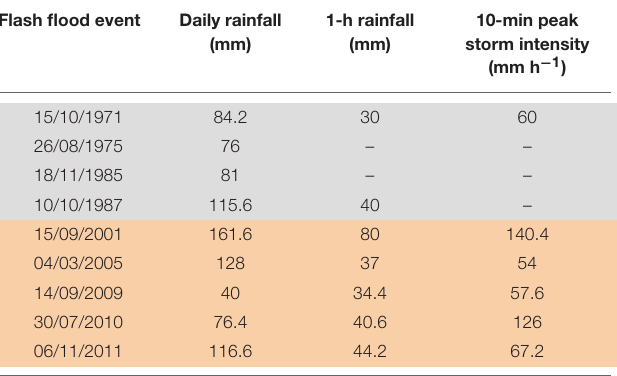
TABLE 5 | Rainfall properties related to the flash flood events occurred in the Pozzuoli area. Flash flood